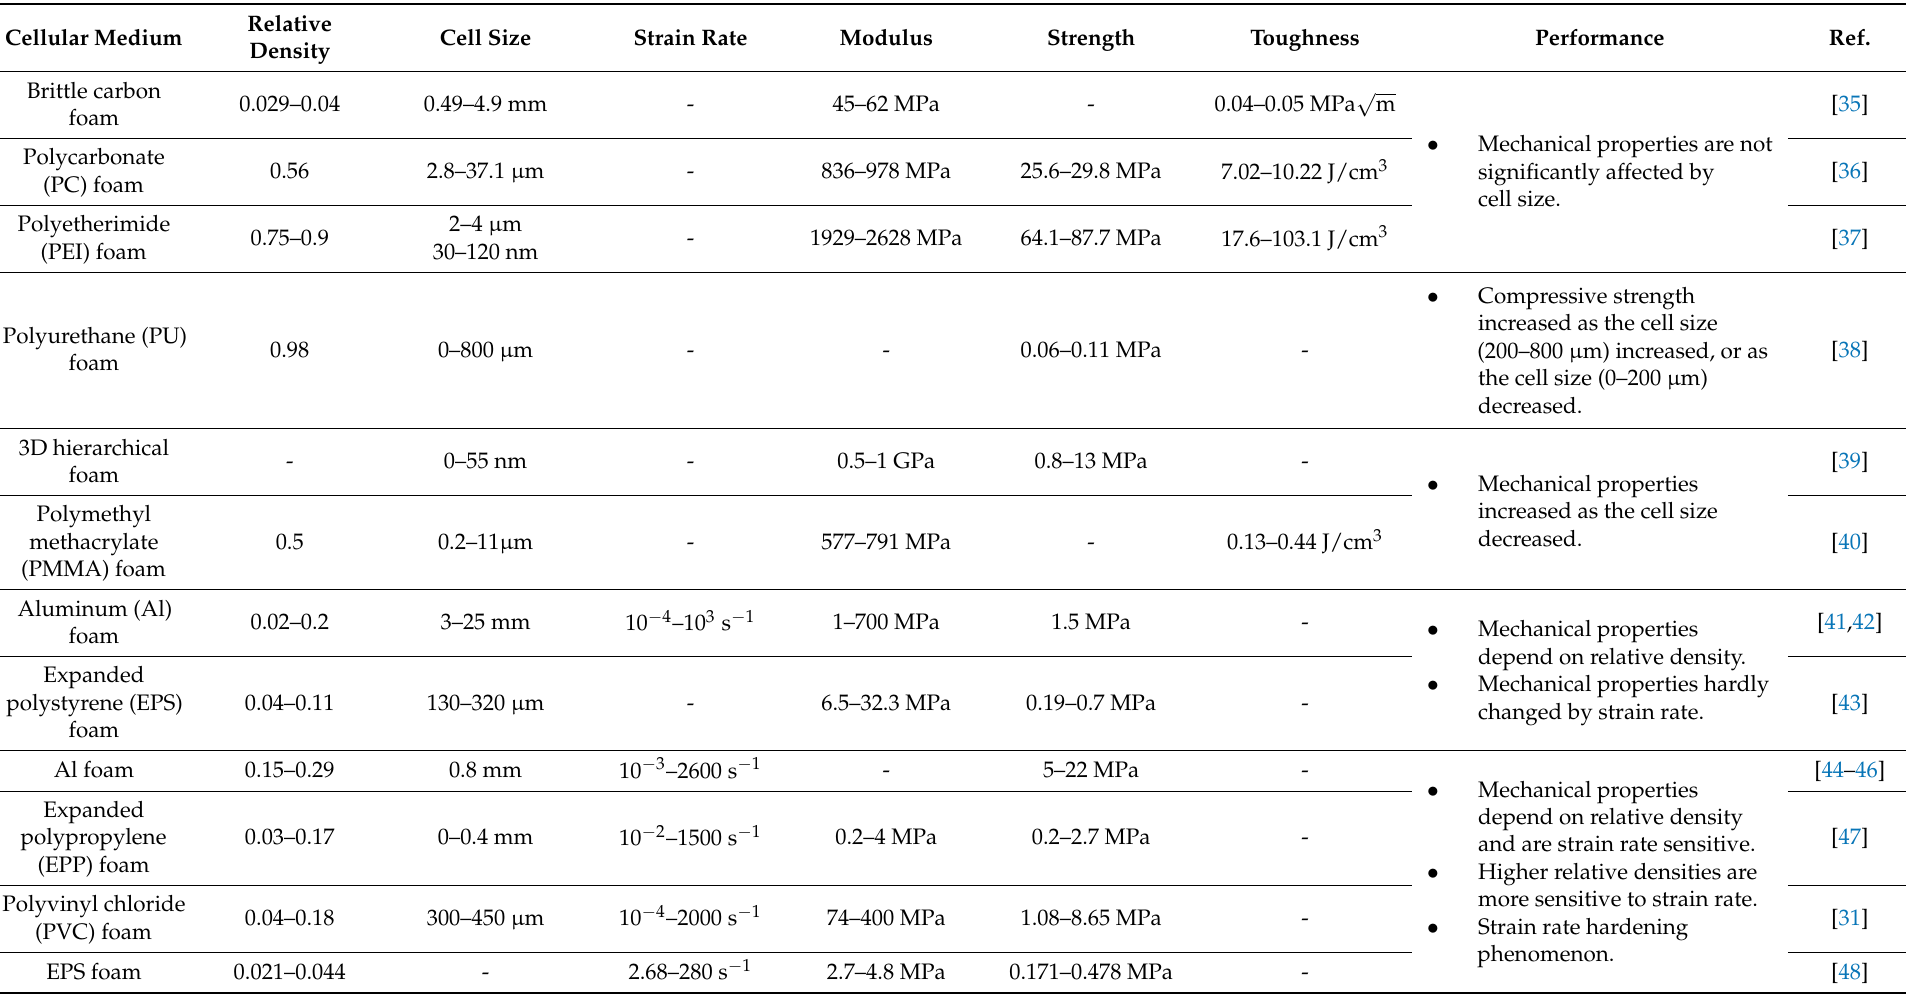
Table 2. Performance comparison of matrix material, relative density, cell size and strain